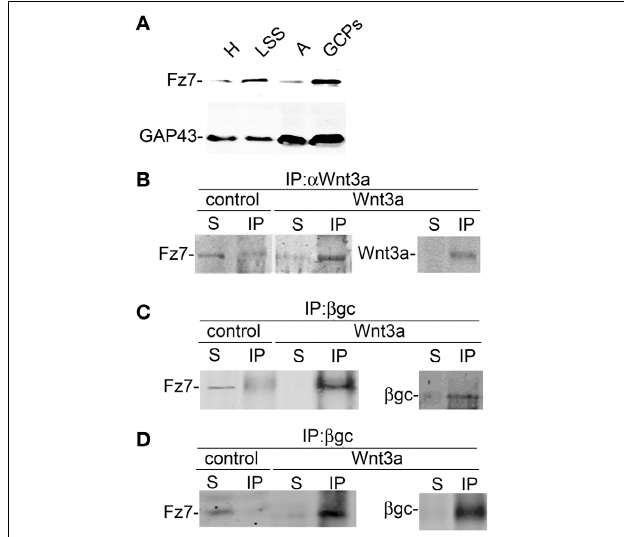
FIGURE 7 | Activation with Wnt3a triggers the formation of a IFG-1r/Wnt3a/Fz7 complex. (A) Fz7 is enriched in GCPs. Western blot analysis of the distribution of the Wnt receptor Fz7 in different subcellular fractions of fetal brain: homogenate (H), low-speed supernatant (LSS), A-fraction (A), and growth cone particles (GCPs). Equal amounts of protein were loaded in all lines. Note the enrichment of Fz7 in GCPs around fourfold compared to (H). A blot showing the distribution of GAP-43, a protein highly enriched in GCPs, was included for comparison. (B , C) Wnt3a triggered the formation of a complex containing IGF-1r-Wnt3a-Fz7. Growth cone particles were incubated in control buffer or in the presence of 1.35nM Wnt3a and immunoprecipitated with (B) Anti Wnt3a and probed with an antibody to the Wnt receptor Fz7 and (C) immunoprecipitated with β gc antibody to pull down IGF-1r and probed with anti Fz7. Immunoprecipitation of Wnt3a and β gc are shown to confirm successful IP and as a loading control. IP, immunoprecipitate; S, soluble fraction after immunoprecipitation. (D) Total protein from hippocampal neurons cultured for 20h in the presence of 1.35nm Wnt3a, deprived of any growth factor for 4h, and stimulated (or not) with 1.35nM Wnt3a for 5min immunoprecipitated with anti β gc antibody to pull down the IGF-1r and probed with anti Fz7. Immunoprecipitation of β gc is shown to confirm successful IP and as a loading control. IP, immunoprecipitate; S, soluble fraction after immunoprecipitation. All blots are representative of at least three independent